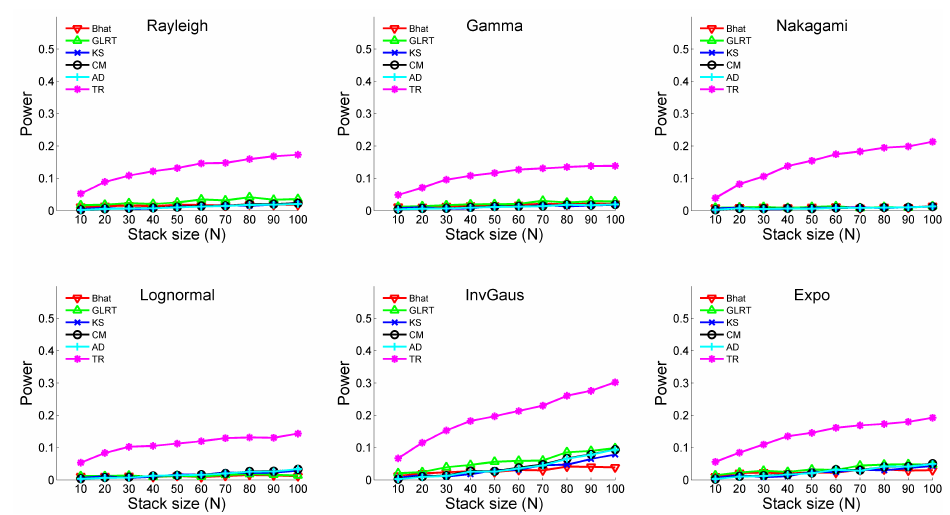
Figure 4. The power of hypothesis tests in case (iii).